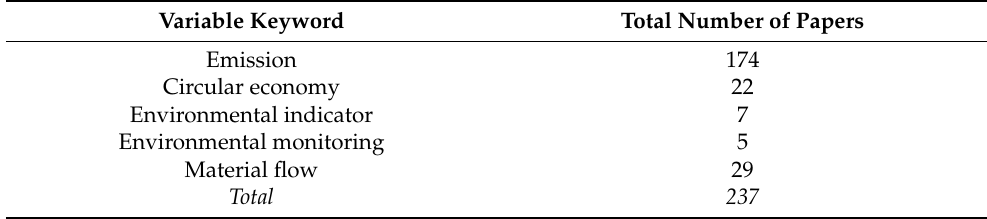
Table 2. Total number of indexed journal articles (research and review articles) published in the years 2019–2023, as found in the Scopus and Web of Science databases. The first column indicates the last and variable research keyword that was combined with “steel” AND “sustainability” through “AND” logical connector. This list refers to the second round of bibliographic research. Numbers refer to the total number of articles, obtained by merging the works found on both databases after removing duplicates. The bottom row reports the total number of found